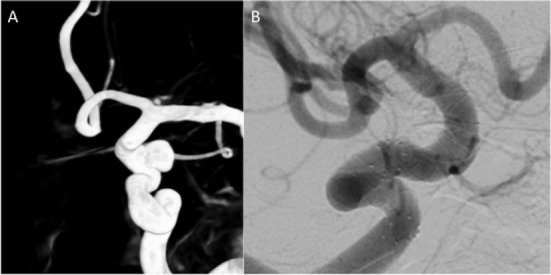
A 6 mm aneurysm can be seen arising from the para-ophthalmic segment of the internal carotid artery (ICA) on the left (A). The aneurysm was treated with two telescoped p64 flow diverting stent (FDS) and the 3-month follow-up angiogram (B) shows exclusion of the aneurysm from the circulation.